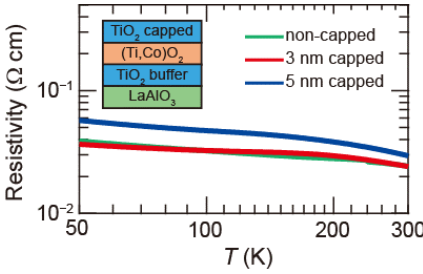
Figure 2. Temperature dependence of resistivity for Ti 0.95 Co 0.05 O 2 −δ epitaxial thin films with the capping layer of nonmagnetic TiO 2 epitaxial thin films. The capping layer thickness was 0, 3, and 5 nm.